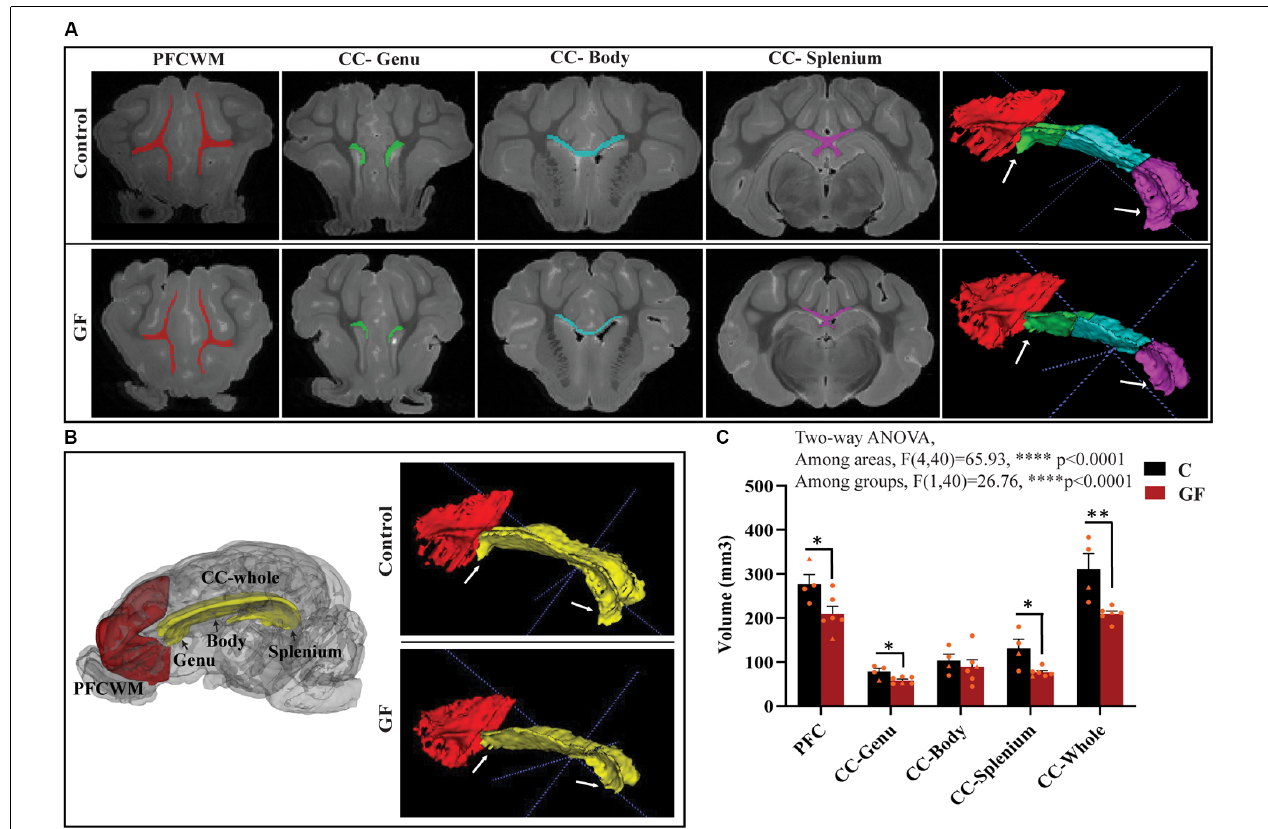
FIGURE 2 | Reduced white matter volume in the prefrontal cortex and corpus callosum in germ-free piglets at 16 days of age. (A) Representative coronal planes of MRI images and 3D segmentations illustrating traced regions of interest: PFCWM (red), CC-Genu (green), CC-Body (cyan), and CC-Splenium (magenta). PFCWM, prefrontal subcortical white matter; CC, corpus callosum. (B) 3D cartoon of and 3D segmentation of PFCWM (red) and CC-whole (yellow). Black arrows indicate subregions of the CC. White arrows demarcate the CC-genu and CC-splenium. (C) Quantification of white matter volumes (mm 3 ) in control (C) and germ-free (GF) piglets. Individual male and female animals are marked by orange triangles and circles, respectively. Data expressed as mean ± SEM, n = 4–6 animals/group. ∗∗∗∗ p < 0.0001, two-way ANOVA; ∗ p < 0.05, ∗∗ p < 0.01, unpaired student’s t -test P16-C vs.